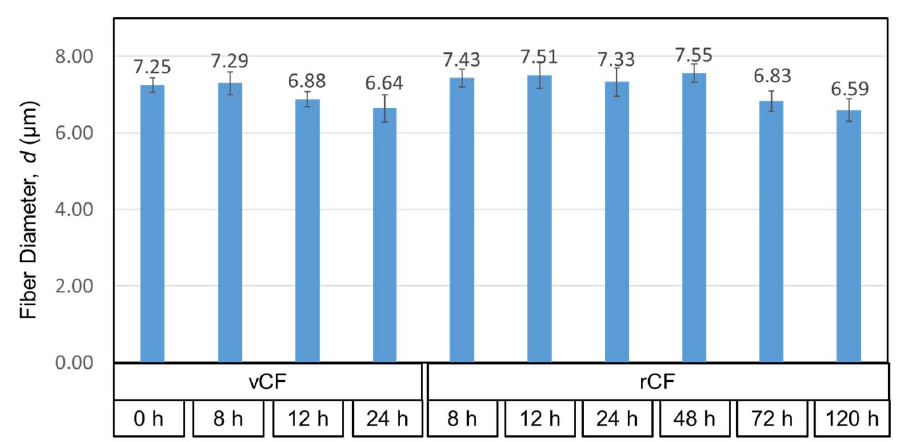
Figure A2. ( a ) Schematic image of microdroplet test, ( b ) interfacial shear strength versus embedded lengths of the resin droplet for representative plots such as vCF and rCF 24 h.